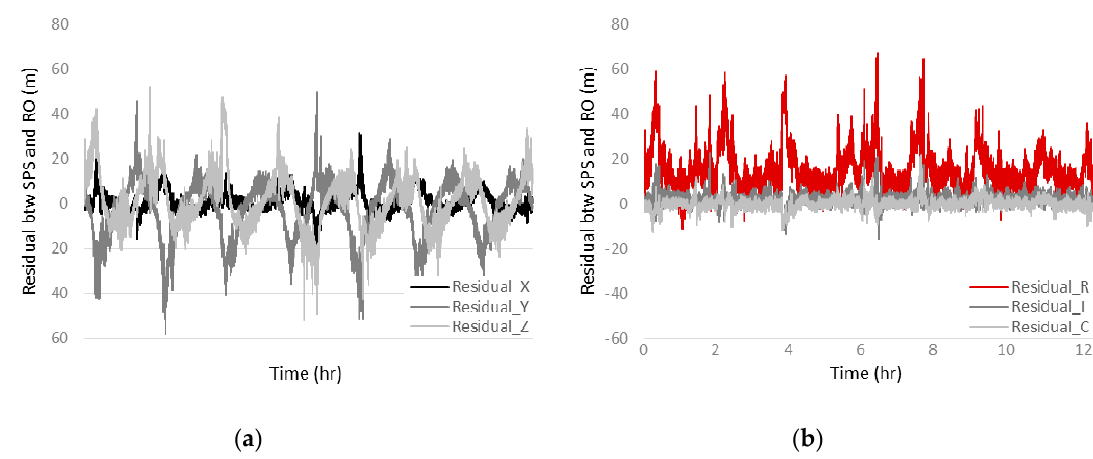
Figure 5. Ionospheric time delay represented according to the frame. If there are ionospheric time delay errors: ( a ) the error is distributed in all axes in the Earth-centered inertial (ECI) frame; ( b ) the error is focused in the radial axis of the RIC frame. The other axis appears to contain only noise error without the effect of ionospheric time delay.